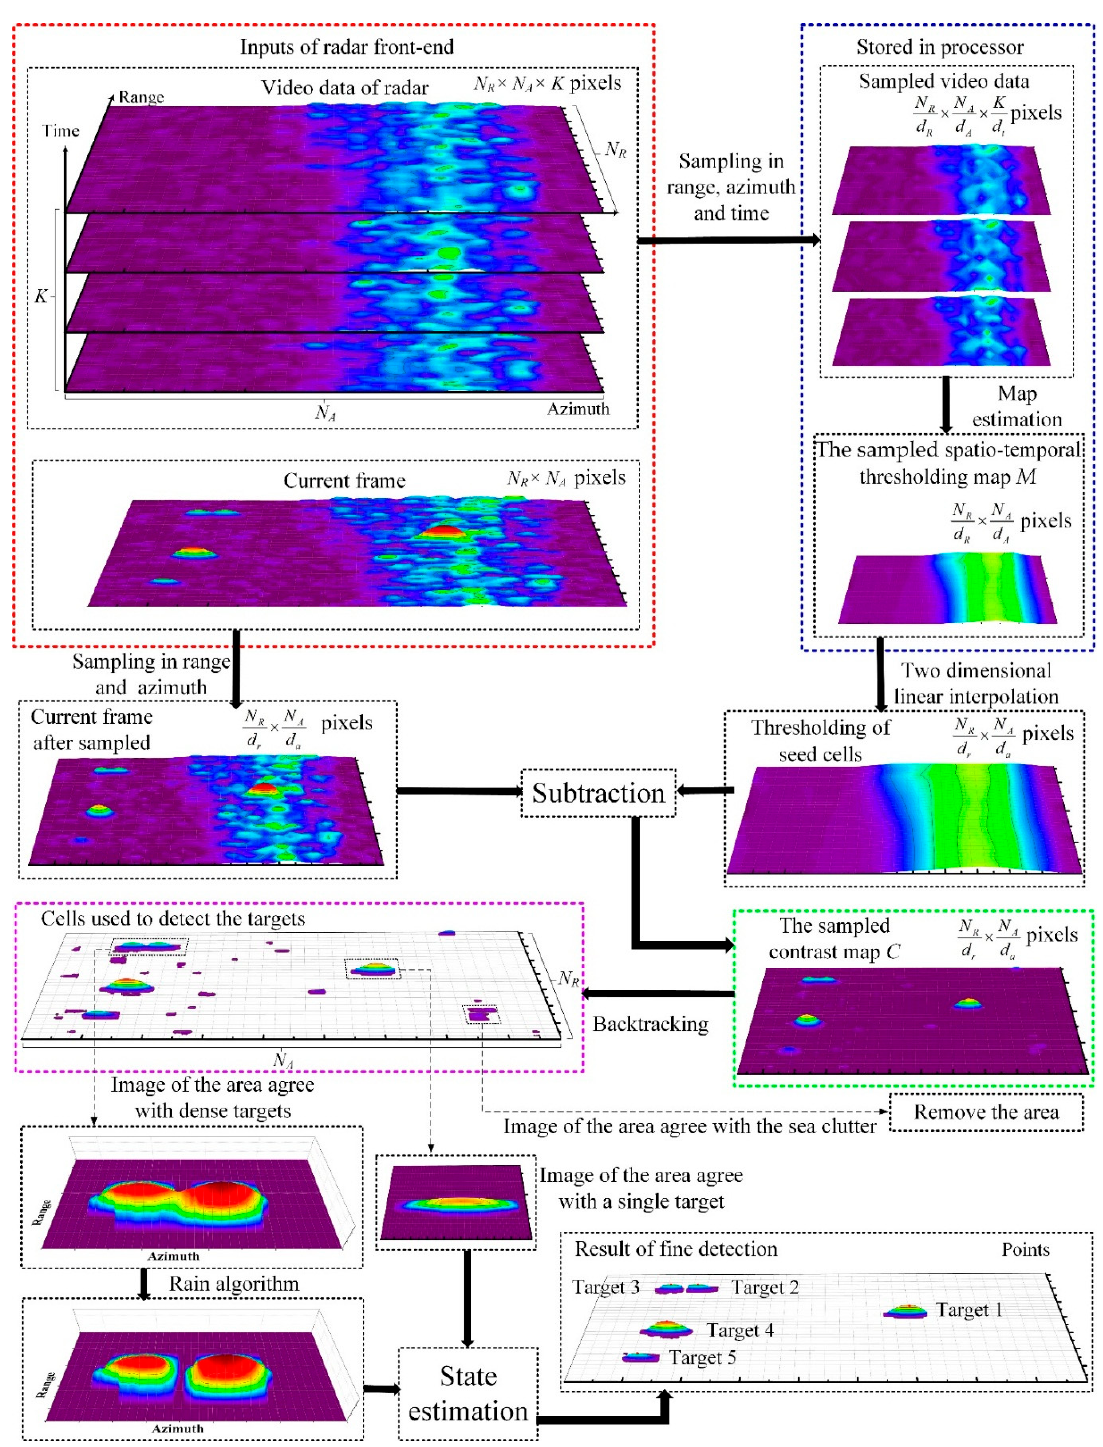
Figure 6. The schematic diagram of the proposed detection framework.